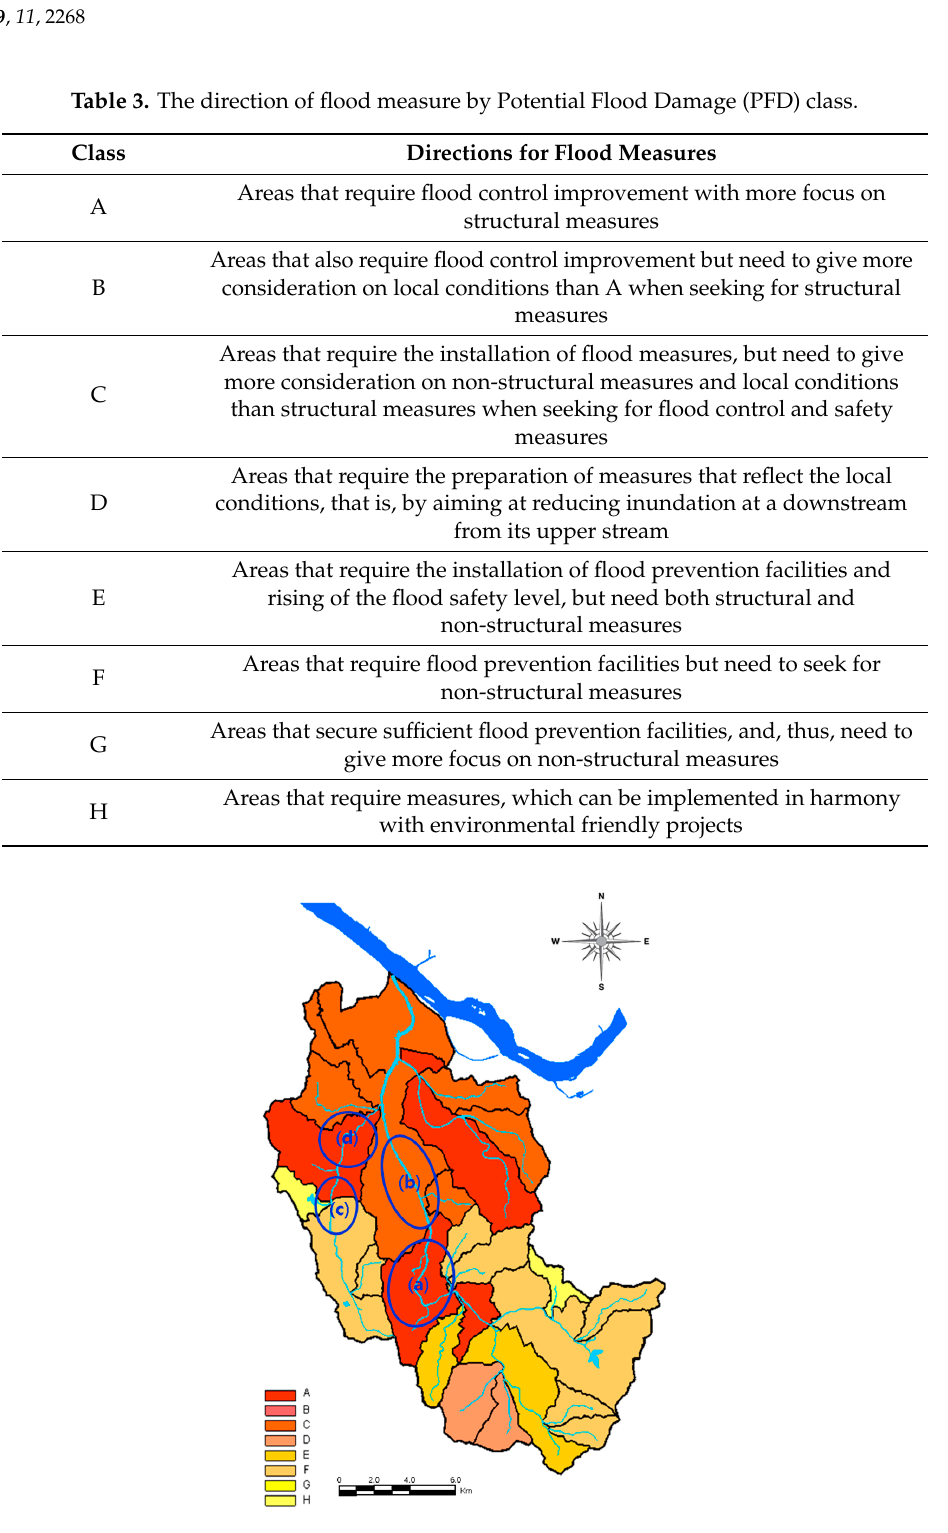
Figure 6. Potential flood damage (PFD) result of Anyangcheon basin (Anyancheon main stream: ( a , b ) / Mokgamcheon stream: ( c , d )); Each area is the same as the one shown in Figure